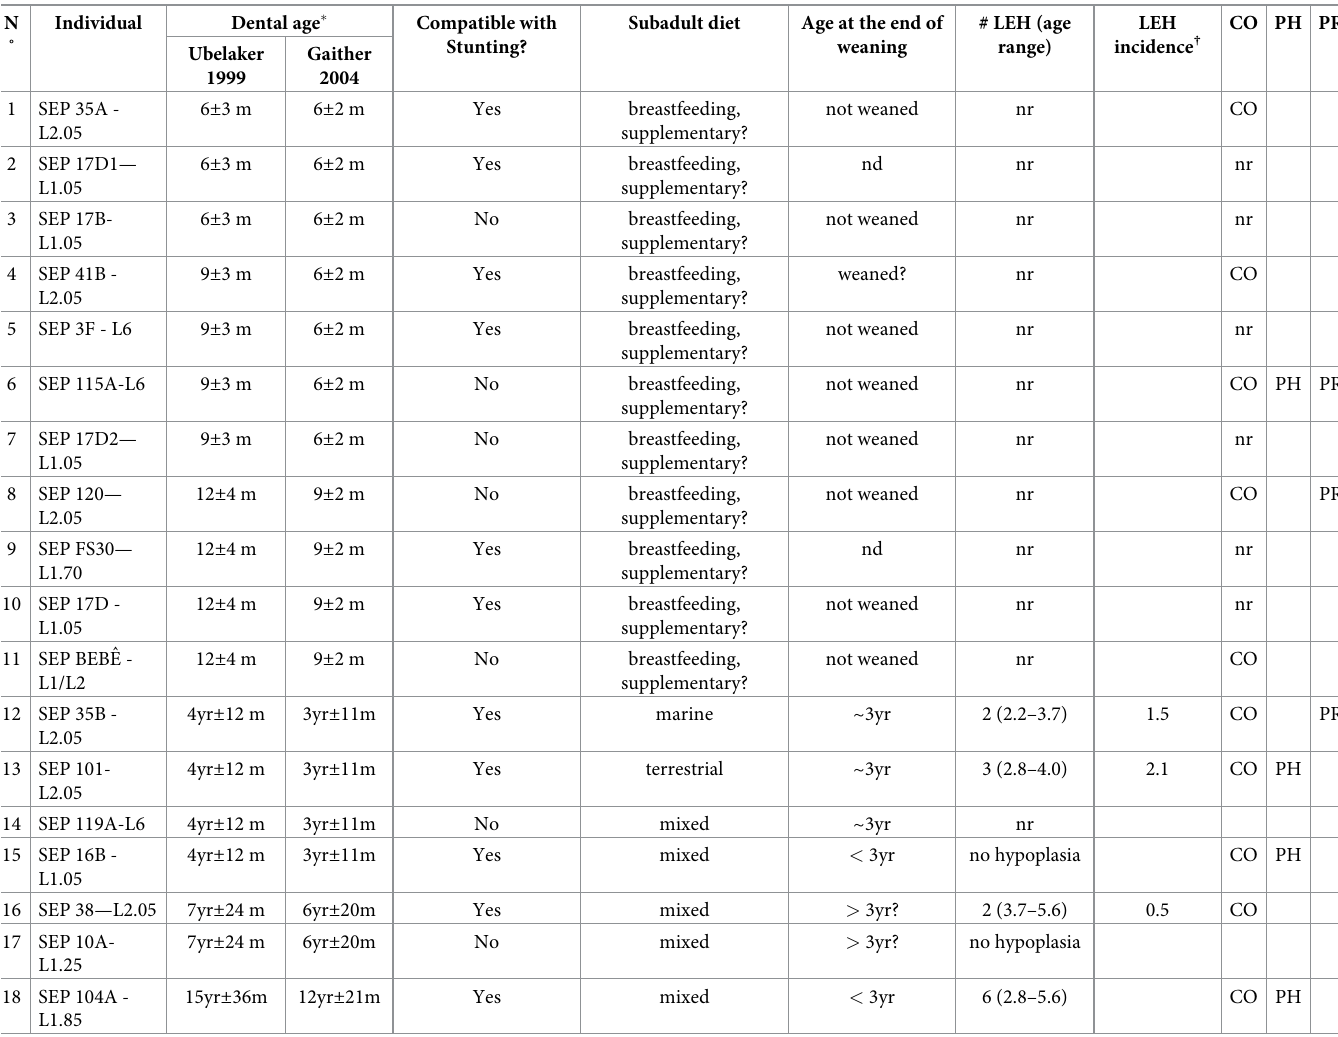
Table 5. Osteobiographic aspects in juveniles from Jabuticabeira II (n = 18). N ˚